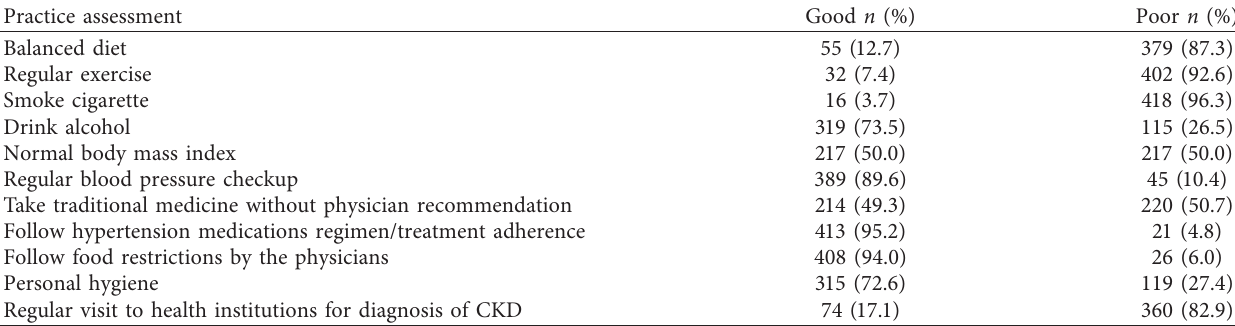
Table 3: Practice assessment towards CKD among hypertensive patients at Gondar town in 2019.